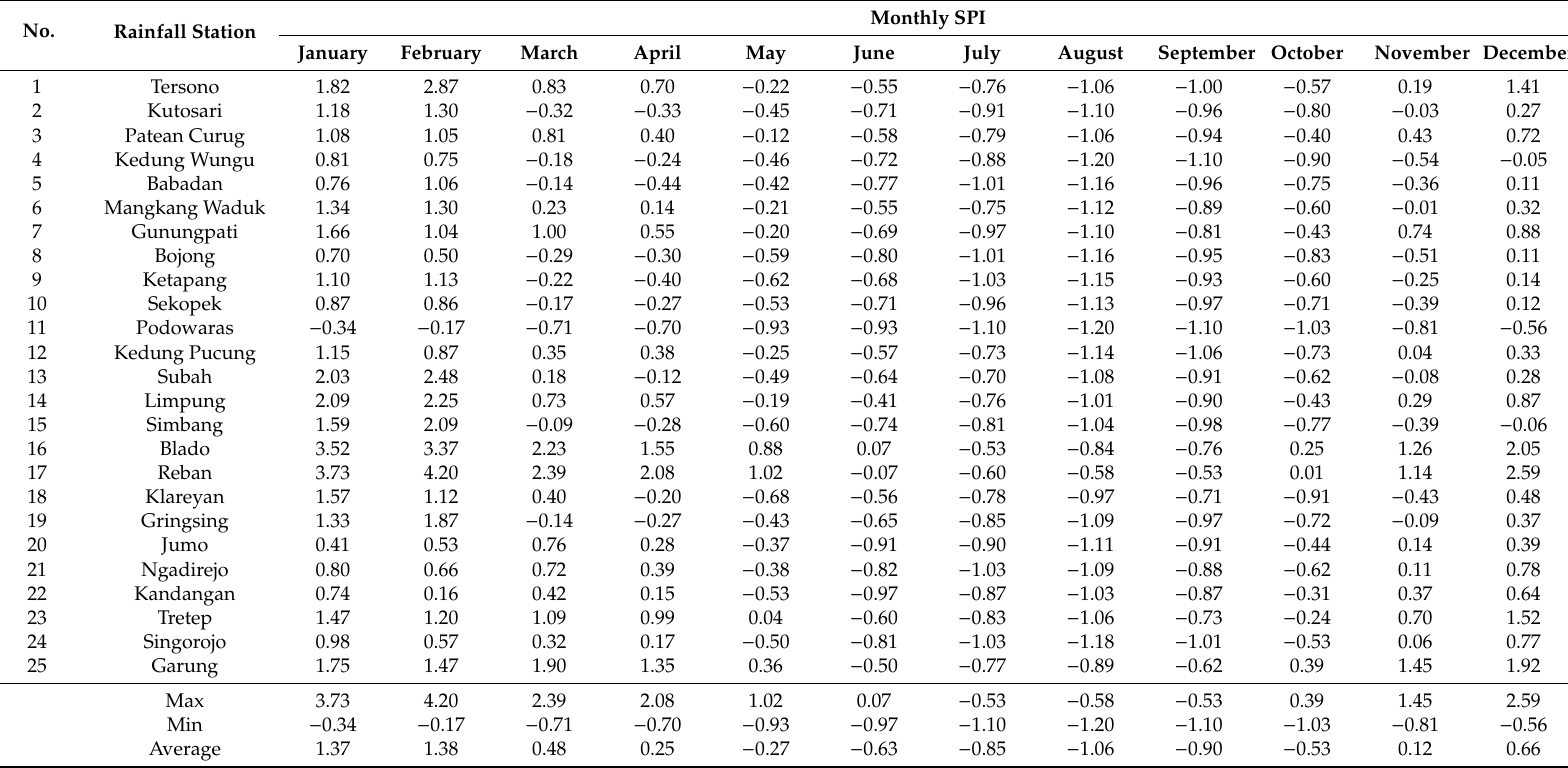
Table 5. Monthly SPI at 25 rainfall